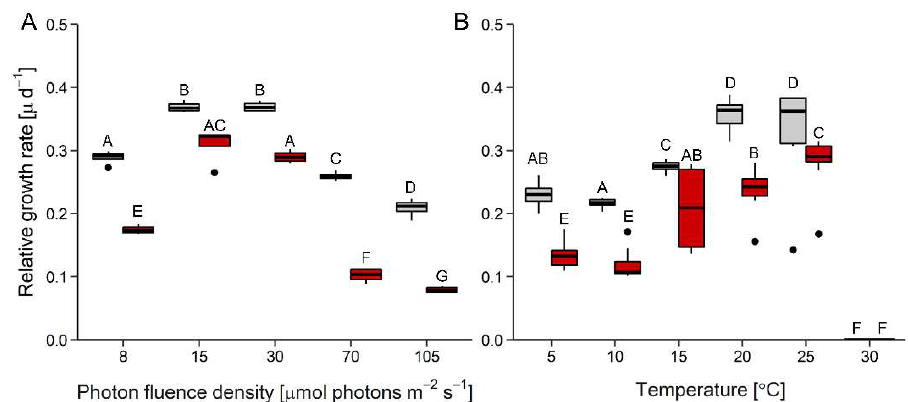
Figure 1. Effects of photon fluence density and temperature on growth. Panels ( A ) and ( B ) show relative growth rates as a function of increasing photon fluence density ( n = 4) and temperature ( n = 8), respectively, in Diplosphaera epiphytica (red) and Edaphochlorella mirabilis (grey). Boxplots show minima and maxima (whiskers), 25th percentiles, medians, and 75th percentiles, and dots are outliers. In each panel, different capital letters indicate significant differences, calculated by pairwise Mann–Whitney U-tests after FDR correction ( p < 0.05).